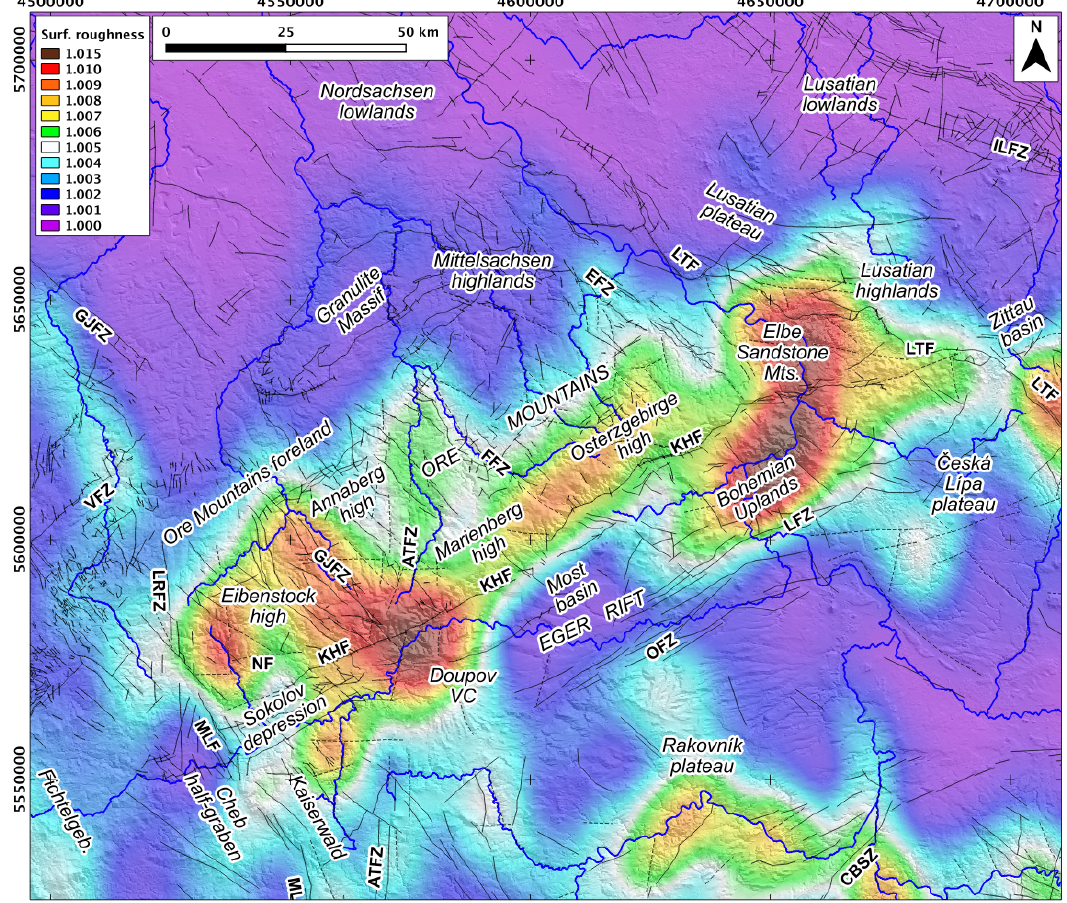
Figure 8. Surface roughness calculated using a 100-pixel moving window. Values increase with topographic elevation and incision by the drainage network. See Figure 2 for the